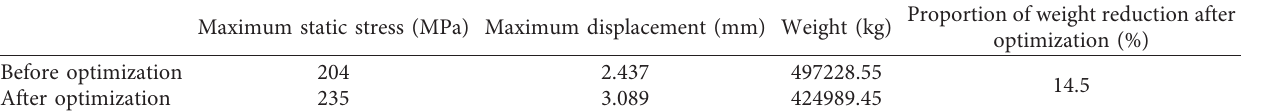
Table 1: Comparison before and after optimization-shear test machine